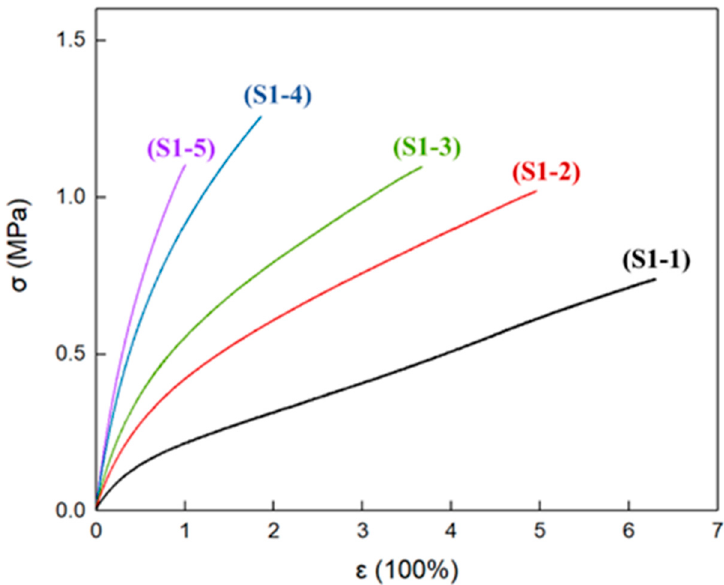
Figure 6. Stress–strain curves of elastomers with different R values at room temperature.